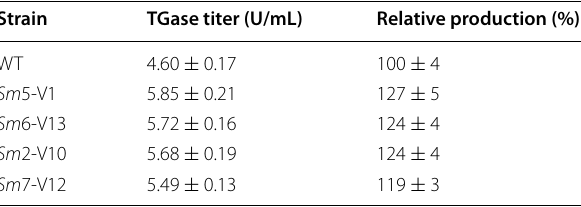
Table 3 TGase production of S. mobaraensis wild-type and ARTP mutants